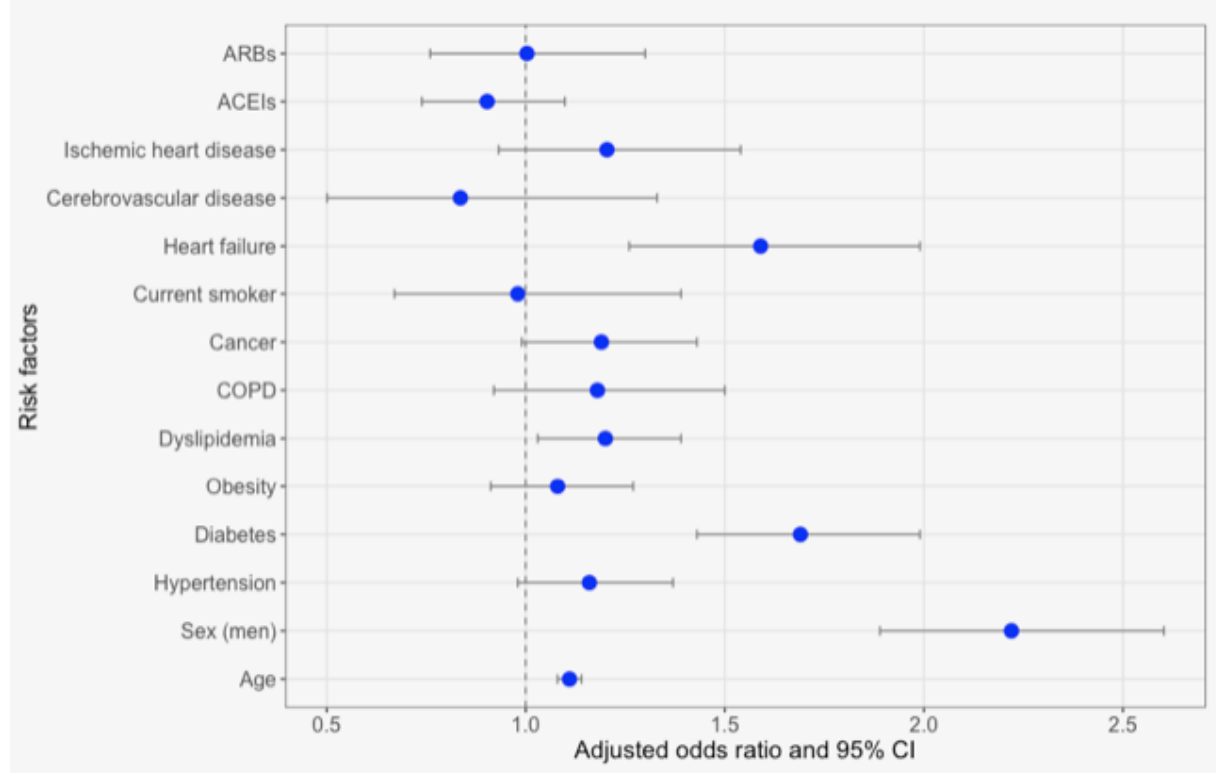
Figure 1. Risk factors associated with mortality in patients with COVID-19. The associations of each risk factor were estimated using logistic regression models adjusted for age and sex; sex was adjusted for age, and age was adjusted for sex. ACEIs: angiotensin-converting enzyme inhibitors; ARBs: angiotensin II receptor blockers; COPD: chronic obstructive pulmonary